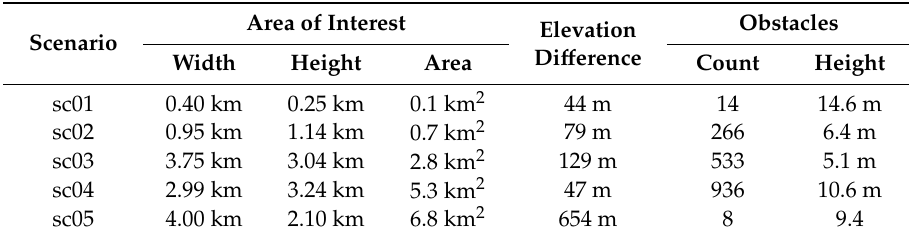
Table 7. Characteristics of the scenario’s environment.